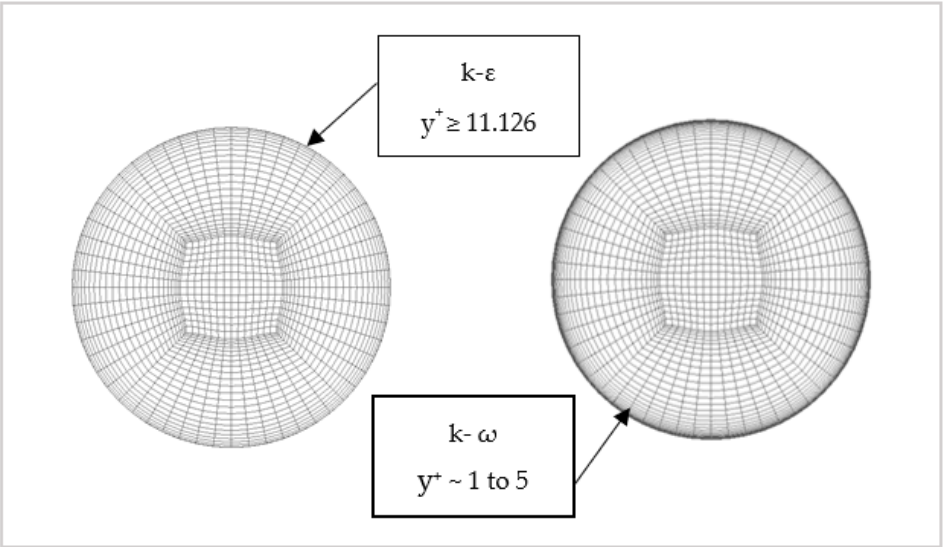
Figure 5. The grid structure in the computational domain.